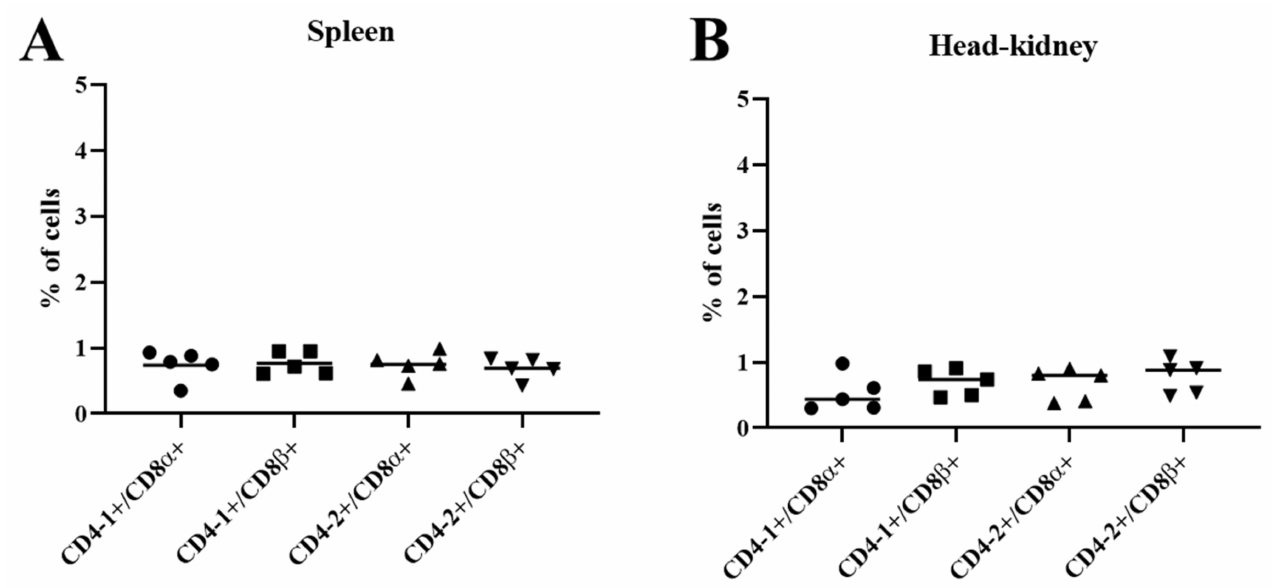
Figure 8. Two color immunofluorescence staining results of CD4 + /CD8 + T lymphocytes in spleen and head-kidney leukocytes. ( A )Percentage of CD4 + /CD8 + cells in spleen. ( B ) Percentage of CD4 + /CD8 + cells in head-kidney. Data represented as mean ± SD of positive cells over total lymphocytes of at least five fish.